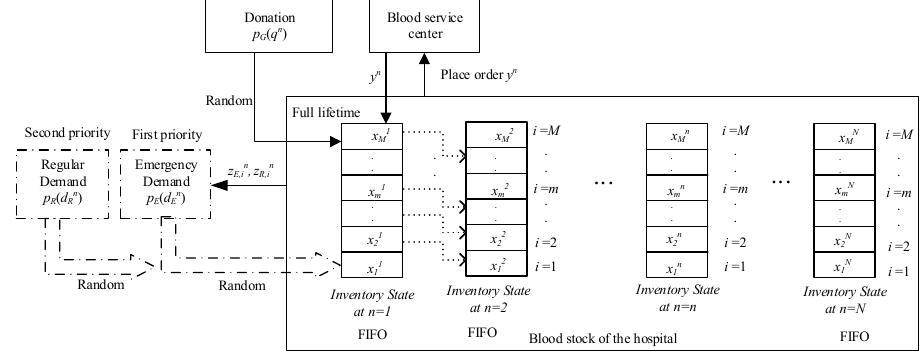
Fig. 2. Model of a periodic blood inventory system with FIFO policy, two supplies and two priority demand classes